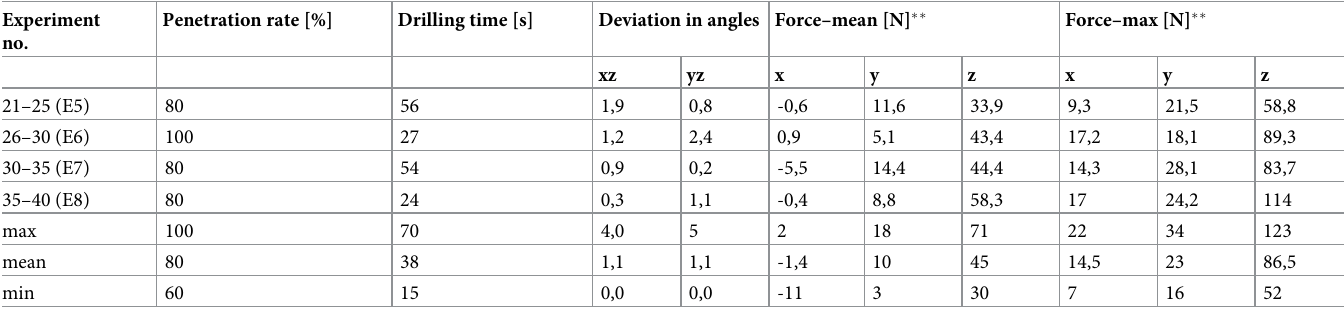
Table 4. Parameters of manual drilling, Part 1 (E+no = mean of 5 drilling procedures). Experiment